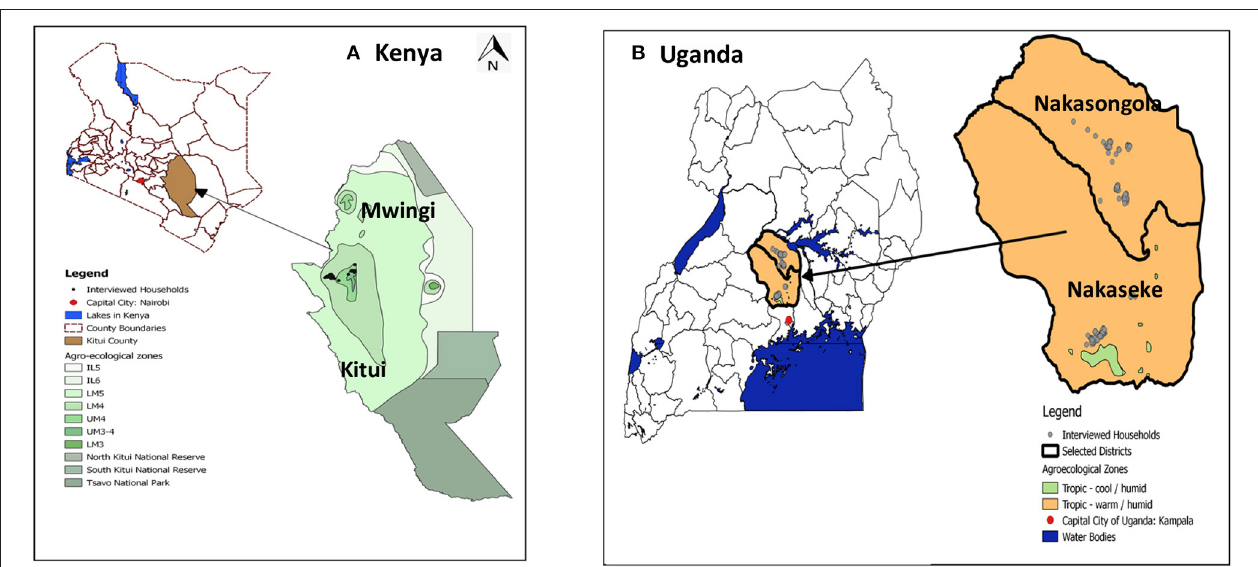
FIGURE 1 | (A) Map showing study sites and agroecological zones of Kitui West and Mwingi West in Kenya and (B) Nakaseke and Nakasongola districts of